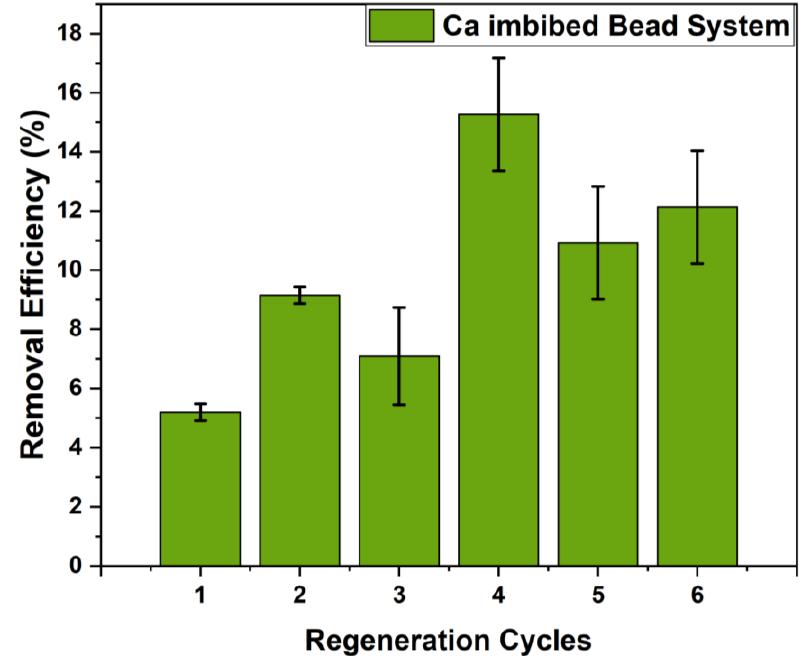
Figure 6. Removal e ffi ciency of 5:1 cross-linked, calcium-imbibed bead systems with ca. 1000 ppm Figure 6. Removal efficiency of 5:1 cross-linked, calcium-imbibed bead systems with ca. 1000 ppm sulfate solution at pH 4–5 over 6 adsorption / desorption cycles and regeneration in 0.1 M CaCl 2 sulfate solution at pH 4–5 over 6 adsorption/desorption cycles and regeneration in 0.1 M CaCl 2 - solution.